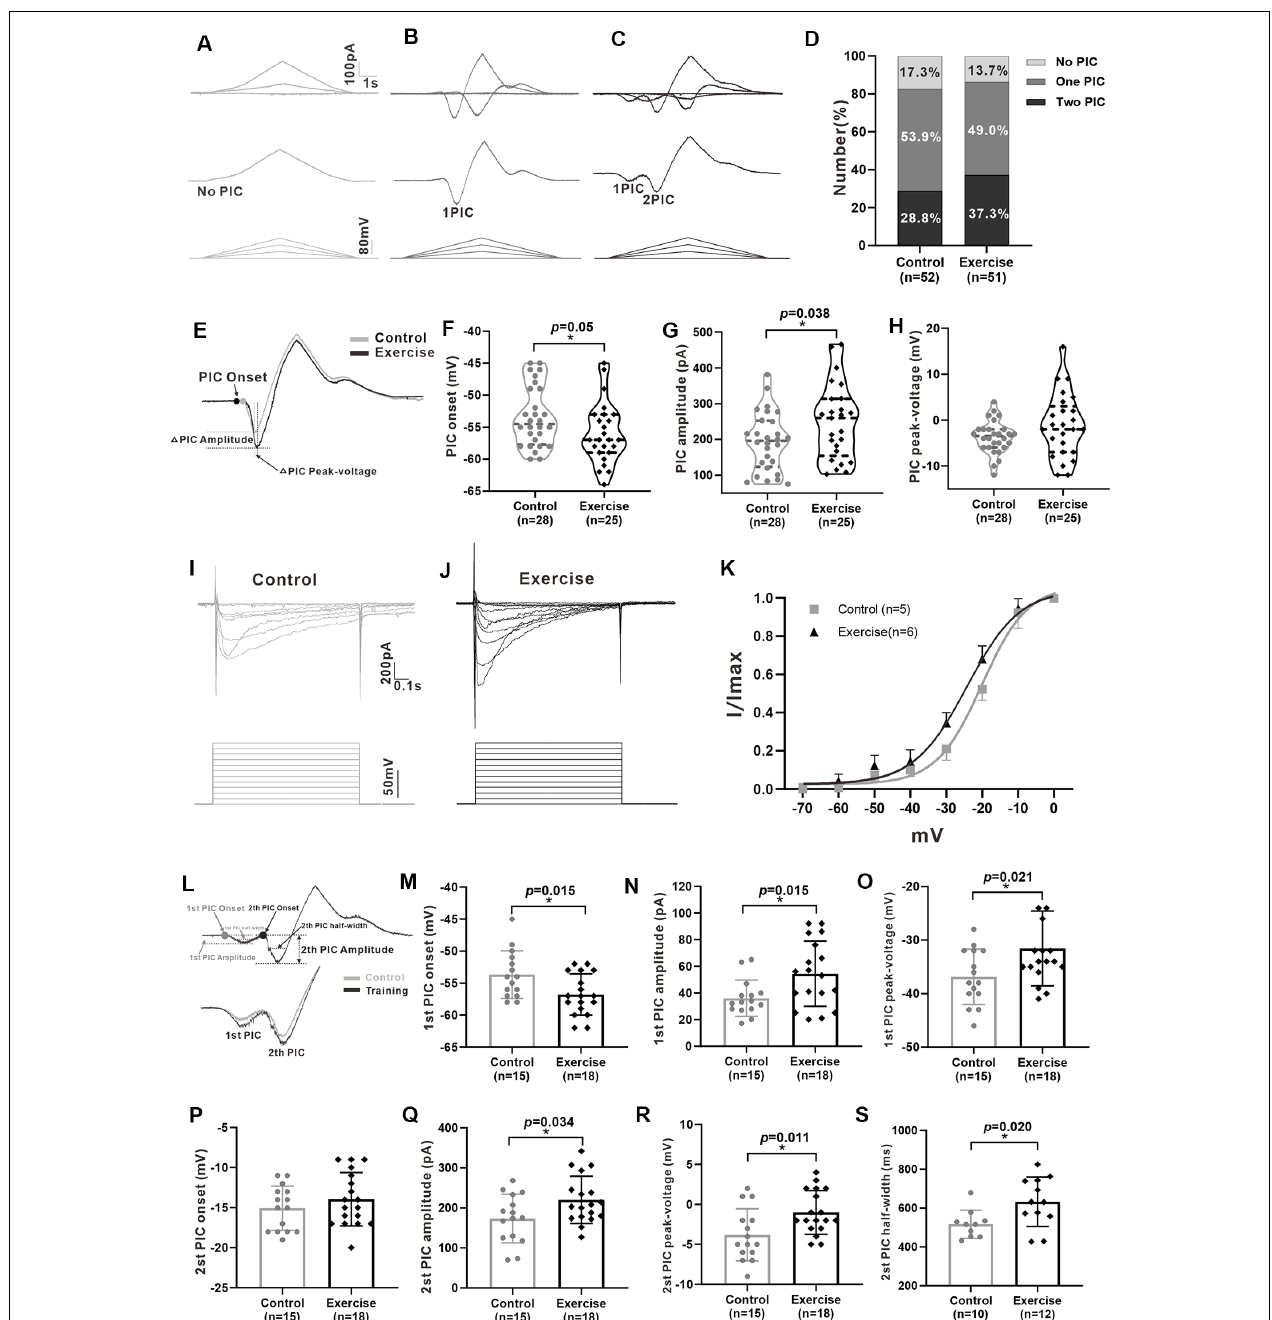
FIGURE 4 | Treadmill exercise enhanced the persistent inward currents (PICs). (A–C) Examples of different patterns of PICs ( A : no PIC; B : one PIC; C : two PICs) in 5-HT neurons. (D) The percentage of different PIC pattern neurons in the control group and the exercise group. (E) Examples of treadmill exercise changed parameters of PICs in neurons with only one PIC. (F) Treadmill exercise hyperpolarized the PIC onset in neurons with only one PIC ( p = 0.050). (G) Treadmill exercise significantly increased the PIC amplitude in neurons with only one PIC ( p = 0.038). (H) There was no significant change in PIC peak-voltage between two groups ( p = 0.235). Examples of PICs elicited by a succession of voltage steps with a step of 10 mV (bottom traces) in the control (I) and exercise groups. (J) PIC traces were used to establish a normalized current–voltage curve, which was then fitted by the Boltzmann function. The kinetic parameters half-maximal activation (Vmid) and activation rate (Vc) were determined for the PICs. Statistical results were shown for voltage dependency of PICs in the control and exercise groups (K) . (L) Measurement of PIC parameters in neurons with two PICs (up) and an example of the effects of treadmill exercise on PICs (bottom). Statistical results showed that treadmill exercise significantly hyperpolarized the onset ( M , p = 0.015) and increased the amplitude ( N , p = 0.015) and peak-voltage ( O , p = 0.021) of the first PIC. (P) There was no significant change in PIC onset of the second PIC between two groups. Statistical results demonstrated that treadmill exercise significantly increased the amplitude ( Q , p = 0.034), peak-voltage ( R , p = 0.011), and PIC half-width ( S , p = 0.020) of the second PIC. * p < 0.05.